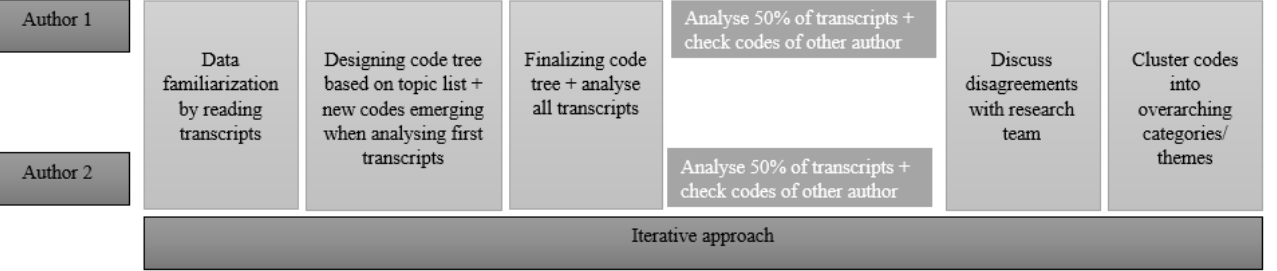
Figure 1. Data analysis process.